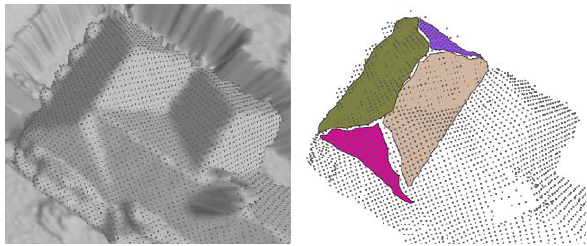
Figure 3. Digital surface model (left) and sub-surface segments of a hipped roof element